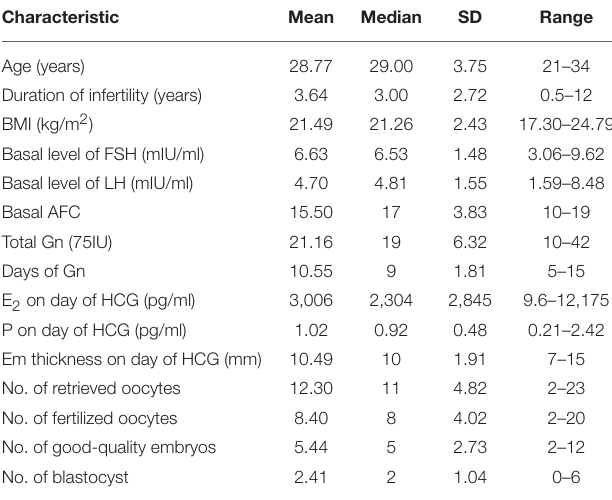
TABLE 2 | Patients characteristics ( n = 54).